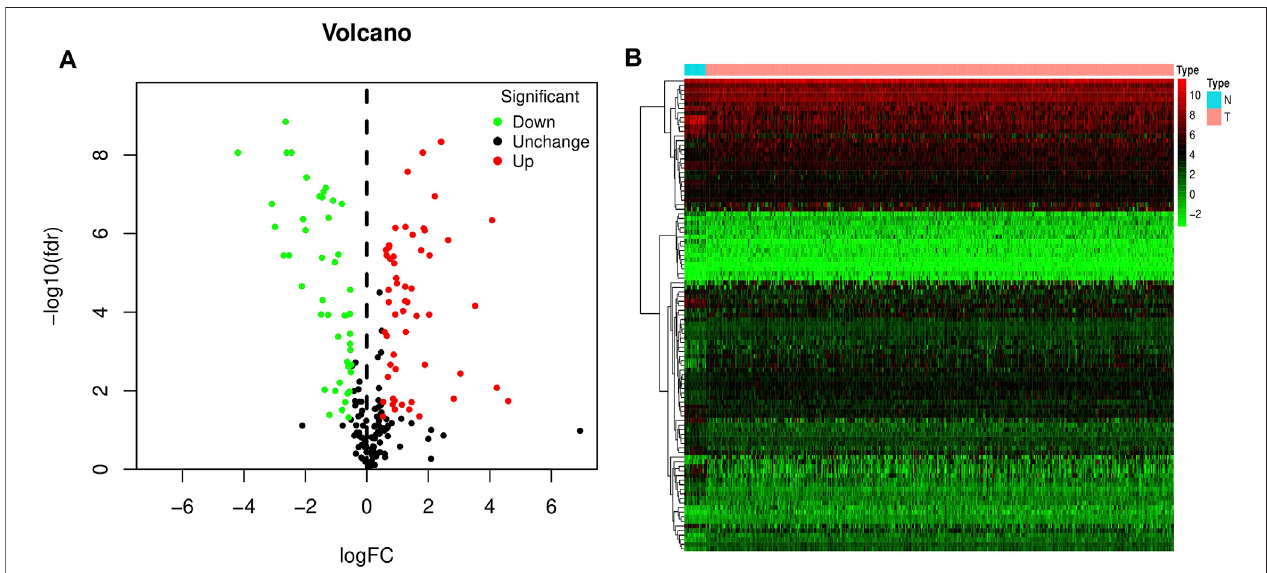
FIGURE 1 | Volcano and heat map of differentially expressed ferroptosis-related genes in bladder cancer. (A) Volcano map. (B) Heat map. Red dots represent upregulated genes, and green dots represent downregulated genes.